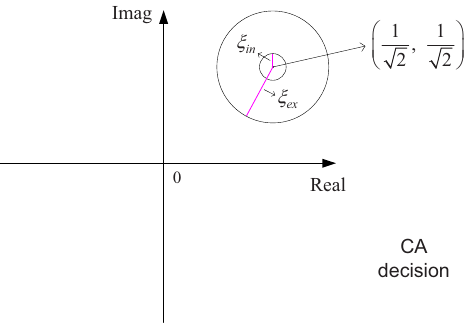
Figure 4. Constellation aggregation